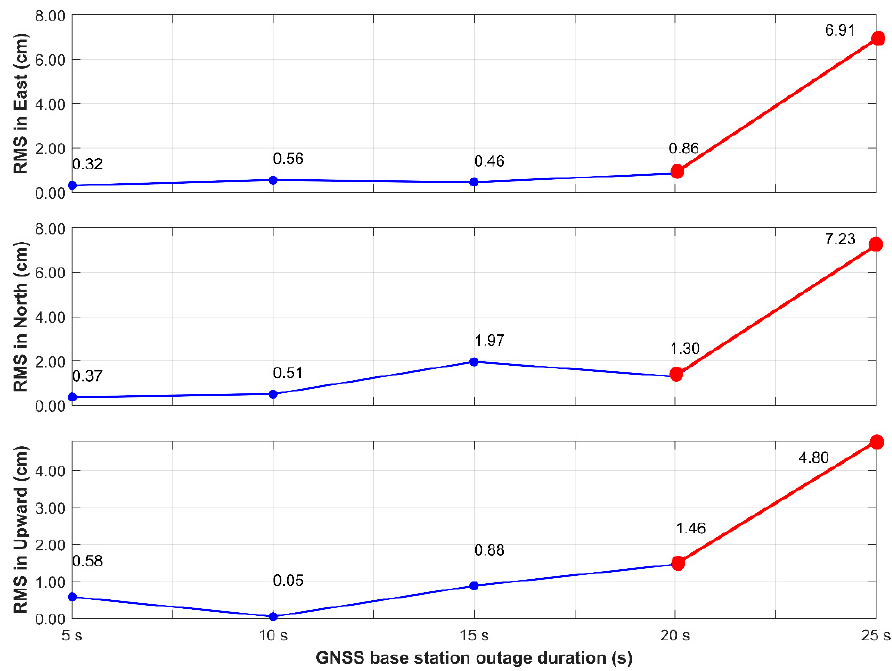
Figure 10. RMS statistical results when simulating landslide sliding period in Scene 2.1 (the red line denotes that the GNSS float solutions appear).